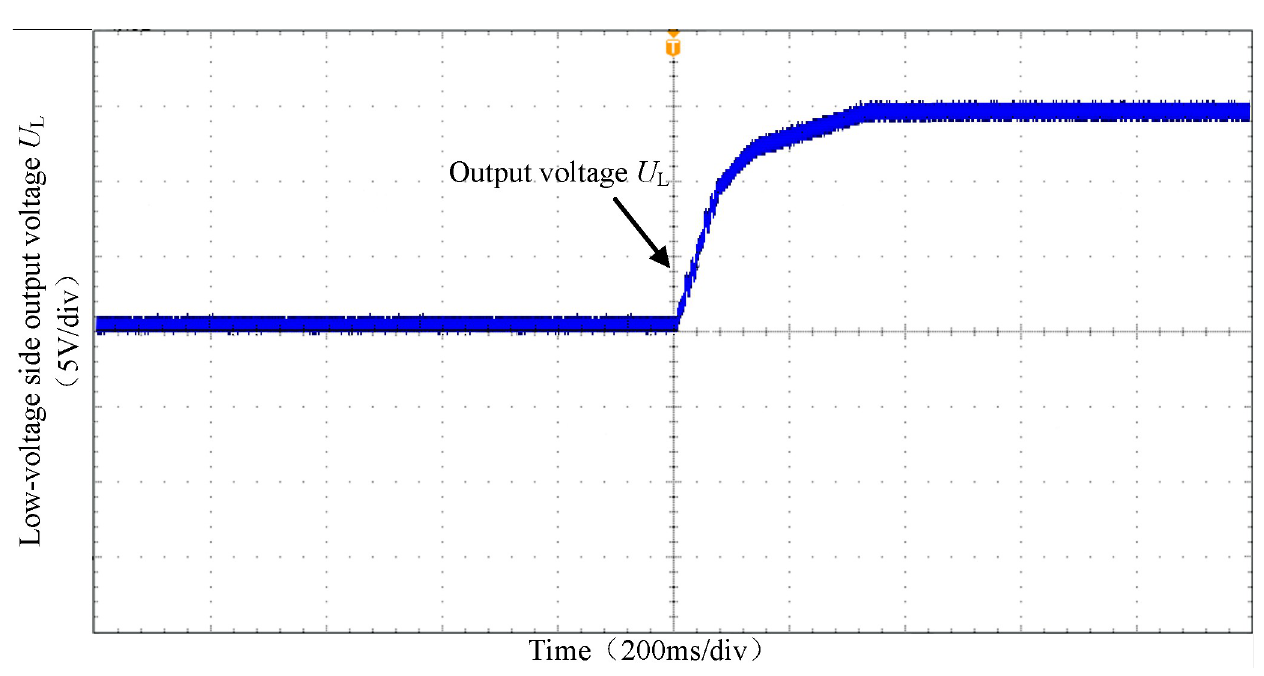
Fig 30. The output voltage waveform of the low-voltage side.